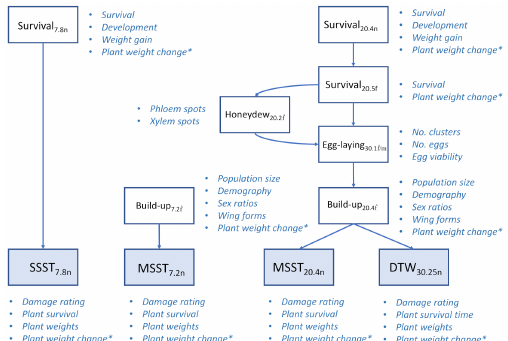
Figure 2. Schematic showing the parameters collected from bulk (SSST and MSSTs) and rapid phenotypic evaluations (DTW test) for plant damage (shaded rectangles) and their relation to performance tests (open rectangles). Performance tests assess resistance (based upon measures of insect fitness) and tolerance (parameters indicated by asterisks). Subscripts indicate plant age at infestation and insect density per plant. See Table 1 for further details related to each